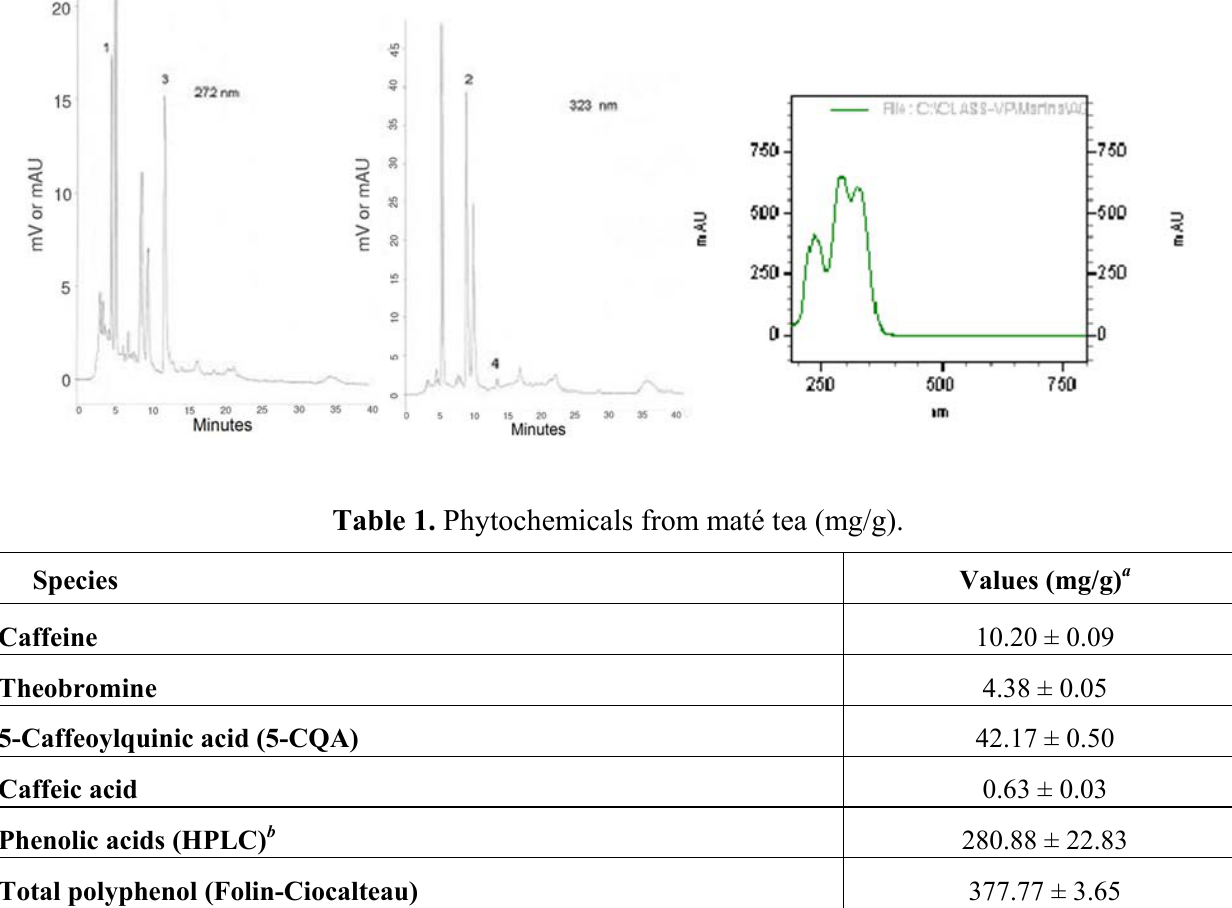
Figure 1. HPLC bioactive compounds profile of the instant maté extract at 272 nm and at 323 nm and UV espectra of caffeoylquinic acids. 1 = Theobromine, 2 = 5-CQA, 3 = Caffeine, 4 = Caffeic Acid.